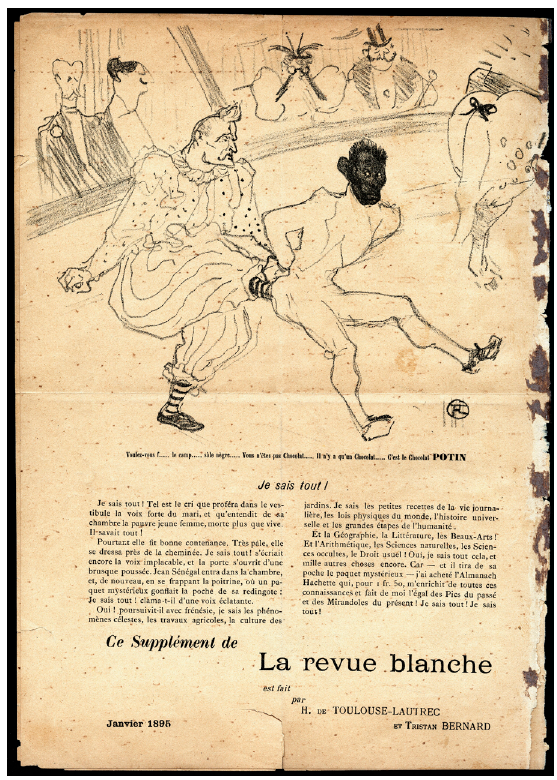
Fig. 2 Henri de Toulouse-Lautrec, ‘Chocolat Potin’, NIB , no. 1, La Revue blanche , 8.1 (January 1895), free-standing